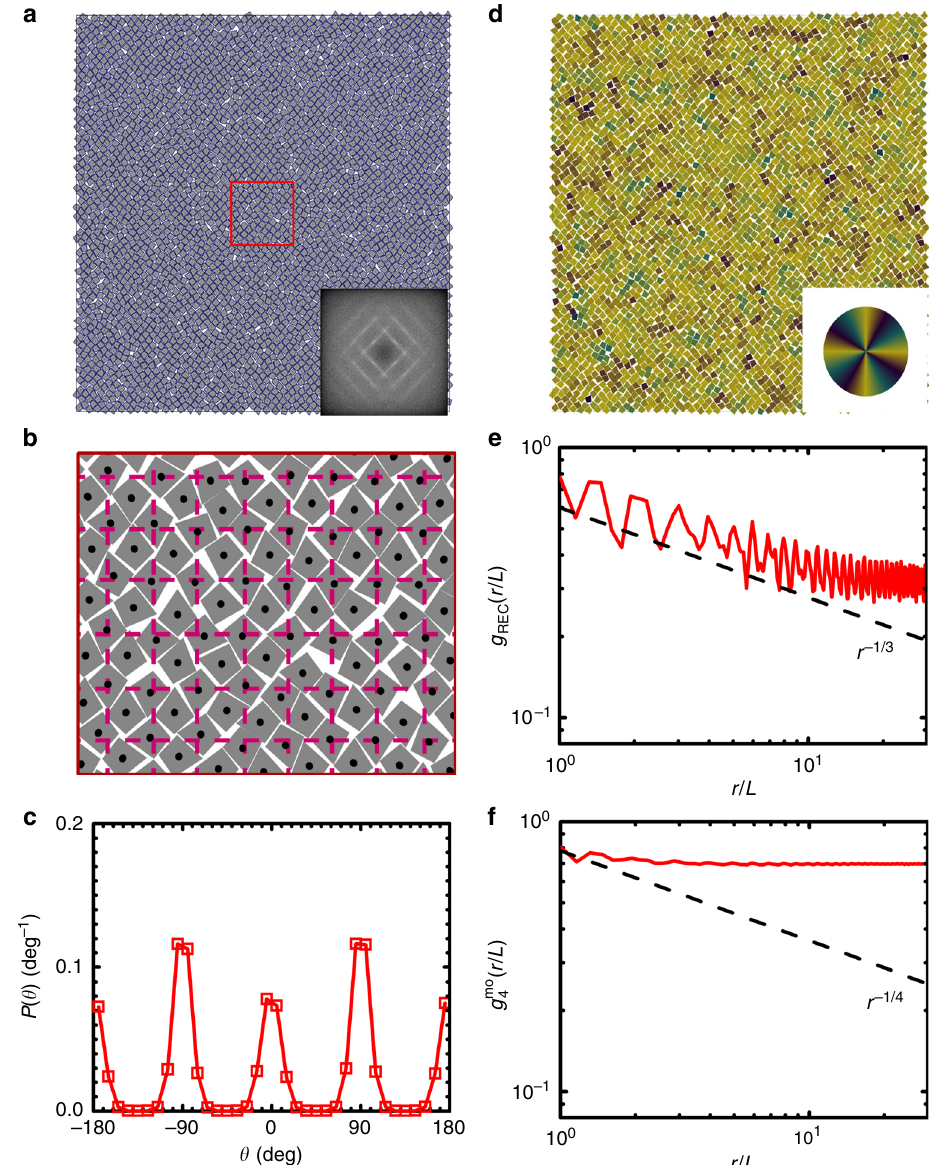
Fig. 2 An example of a TRX phase ( α = 99°, ϕ A = 0.800, NVT ensembles). a A snapshot of a con fi guration of kites. Inset shows the fast Fourier Transform (FFT) of the snapshot. b A magni fi ed view of the enclosed region by the red square in a . Dashed lines show the rectangular lattice, which has lattice constants of 1.45 L and 1.33 L , obtained by maximizing the positional order parameter of the system. c The probability density P ( θ ) of the single particle pointing direction θ . d Con fi guration in a is color-coded by particles ’ pointing directions. Inset shows the color wheel (with fourfold rotational symmetry) used for color-coding particle orientations. e The spatial correlation function of rectangular crystal lattice g REC ( r ). Dashed line is ∝ r − 1/3 , which is the KTHNY prediction for spatial correlation function at the crystal – liquid crystal transition point. f The fourfold molecular-orientational correlation function g 4 mo ( r ). Dashed line is ∝ r − 1/4 , which is the KTHNY prediction for the molecular-orientational correlation function at the liquid crystal-isotropic phase transition